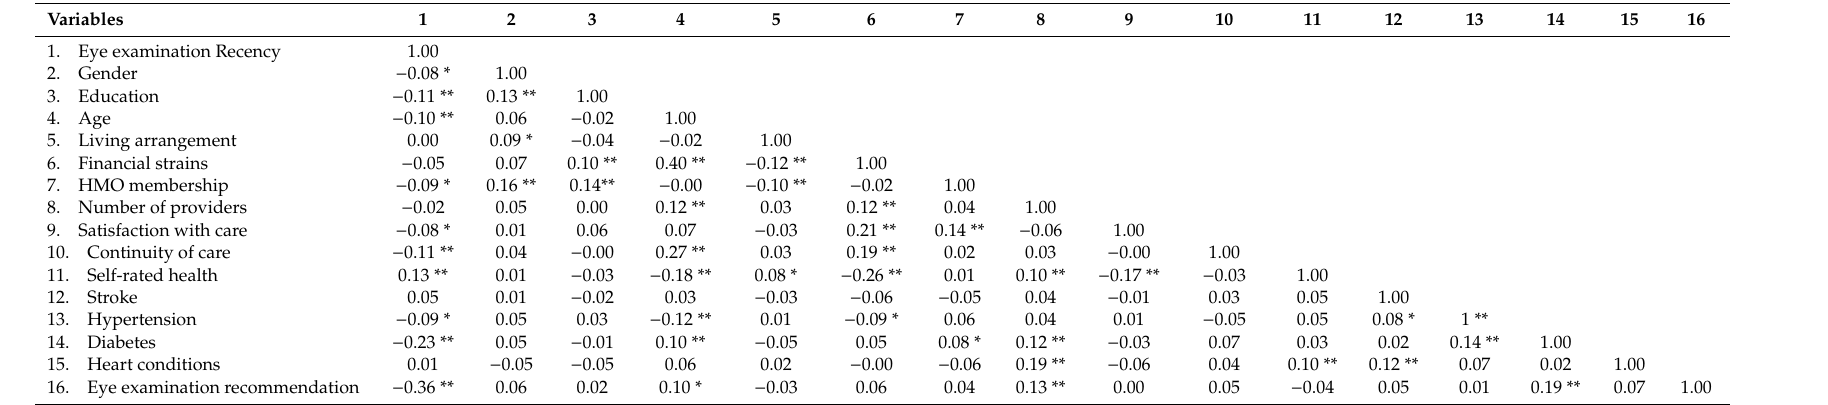
Table 3. Correlations among eye examination and independent variables ( n =